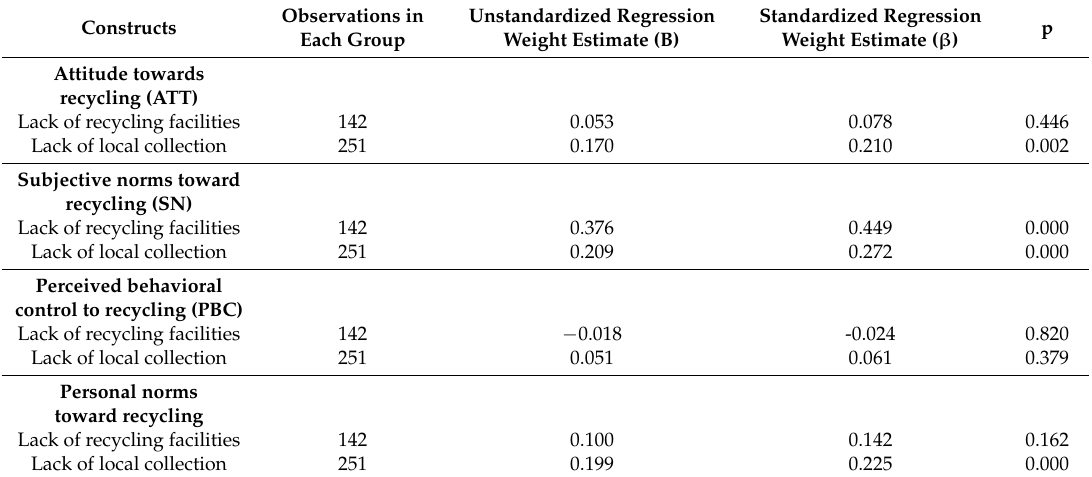
Table 8. Result of Moderation Test of Perceived lack of facilitating conditions on Relationship between Predictors and Intention to